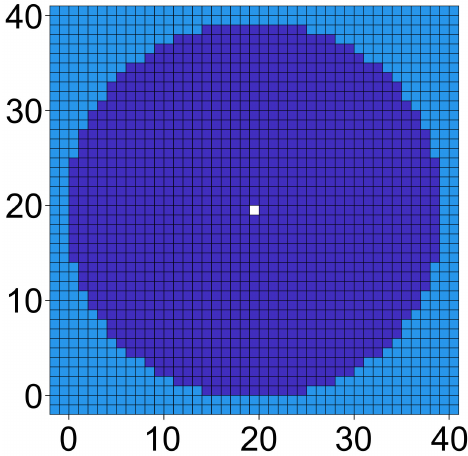
Figure 1. 200 µ m 2D sphere approximated with a diameter of 39 voxels in the horizontal and vertical directions. The central voxel is marked in white. Linear rows of 11 voxels form the horizontal and vertical